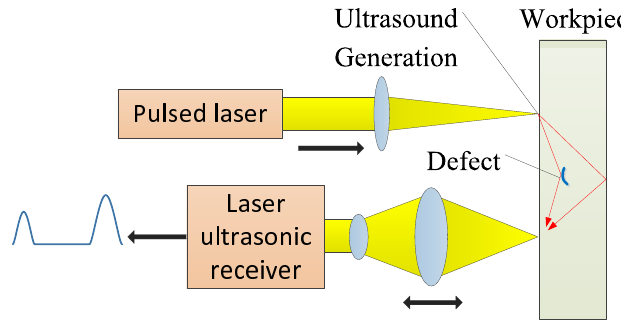
Figure 29. Schematic of laser ultrasonic detection of an internal defect.